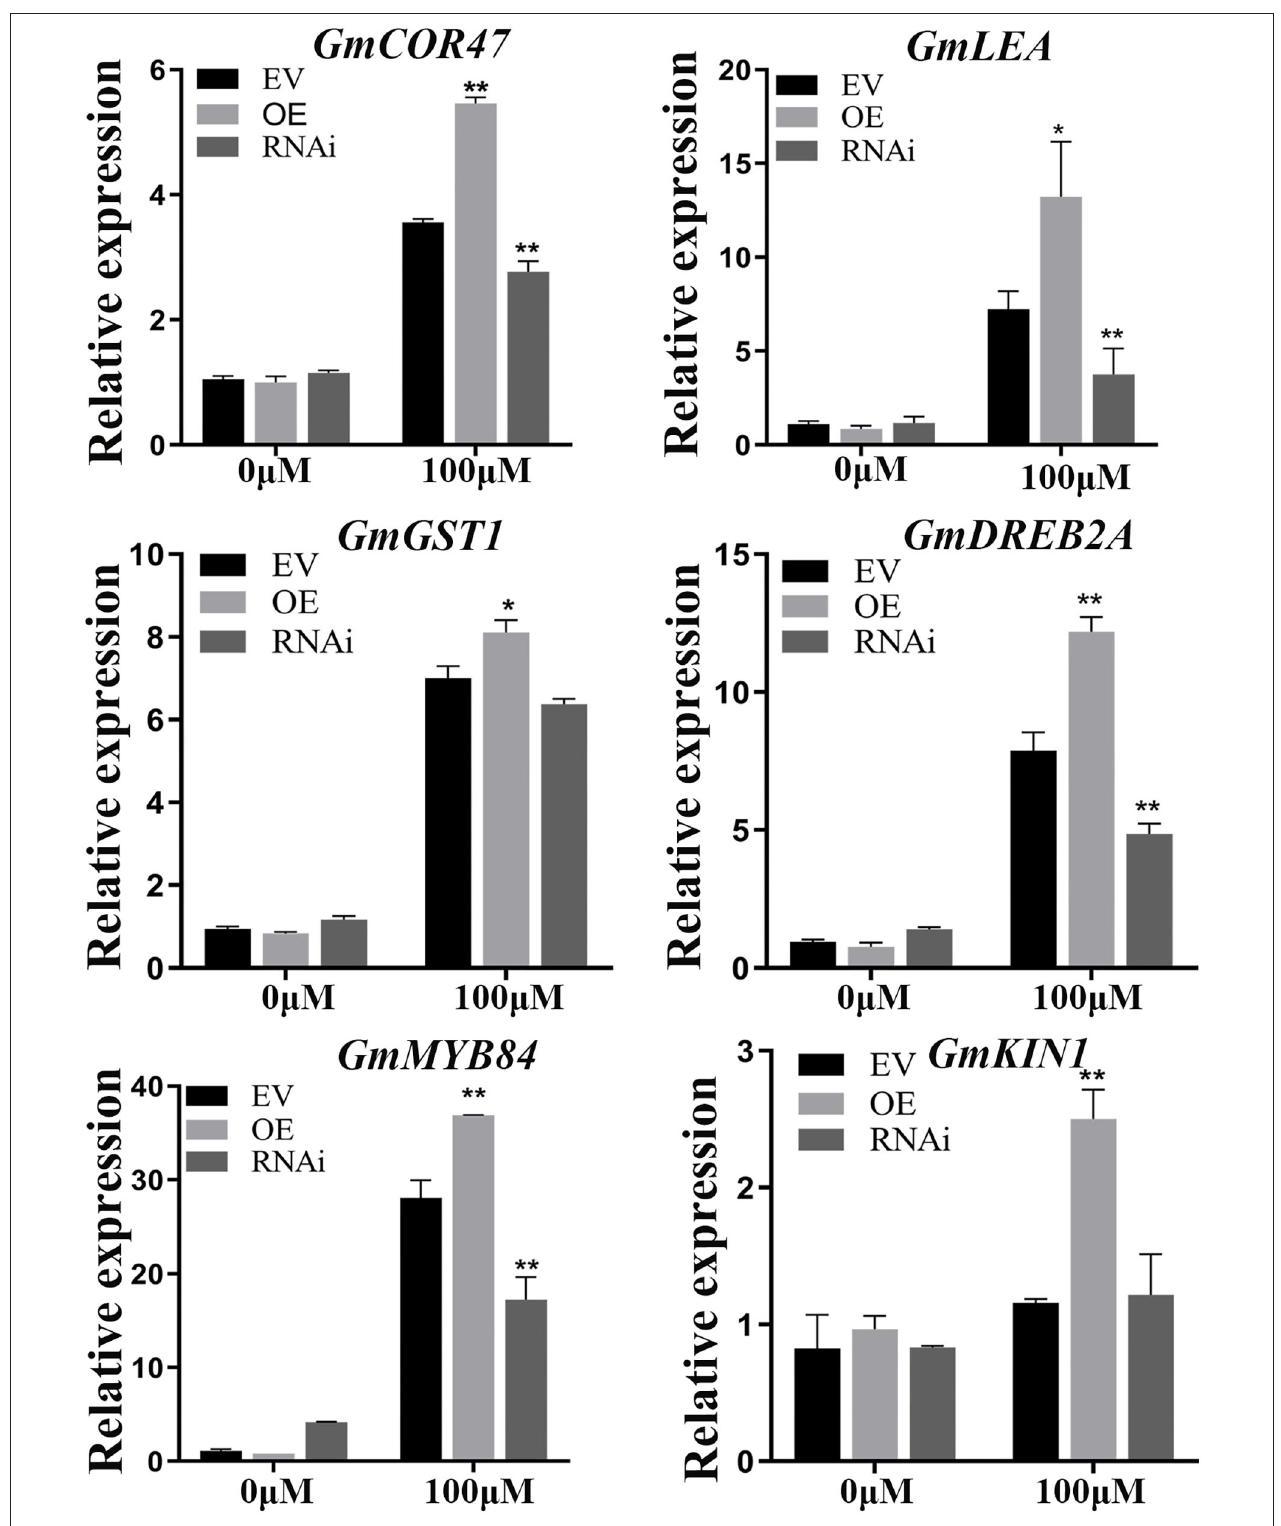
FIGURE 8 | Expression patterns of the stress-responsive genes including GmCOR47 , GmLEA , GmGST1 , GmDREB2A , GmMYB84 , and GmKIN1 . EV, empty vector; OE, overexpressing GmWRKY21 soybean hair roots; RNAi: the hairy roots of GmWRKY21 -RNAi transgenic soybean. The EV, OE, and RNAi soybean hair roots under normal and Al stress conditions. The hair roots were exposed to 0 and 100 µ M AlCl 3 (pH 4.3) for 24h. All data are presented as means ± SEM ( n = 3). Significant differences according to the one-way analysis of variance are denoted as follows: ** P < 0.01 and * P < 0.05.